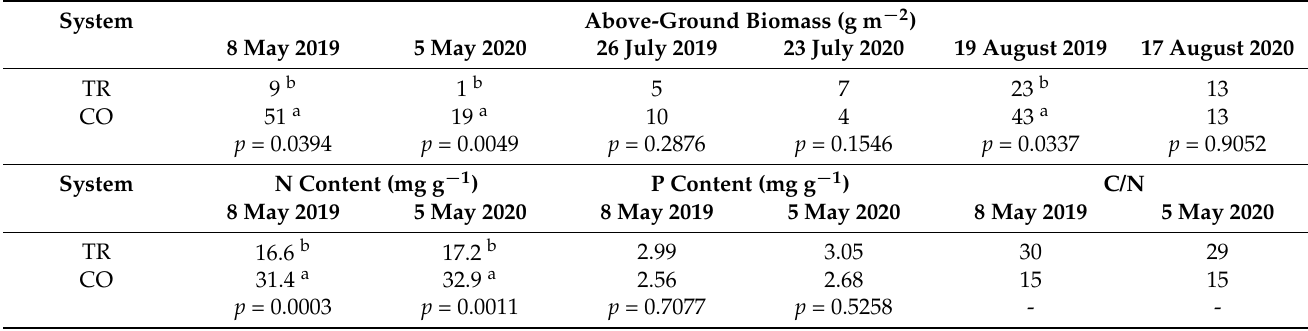
Table 3. Above-ground biomass of weeds (g m − 2 ) in May, July and August. N (mg g − 1 ) and P (mg g − 1 ) content, N and P uptake (kg ha − 1 ) and C/N ratio all measured in May. Different letters are significantly different at p < 0.05 (Duncan test). System